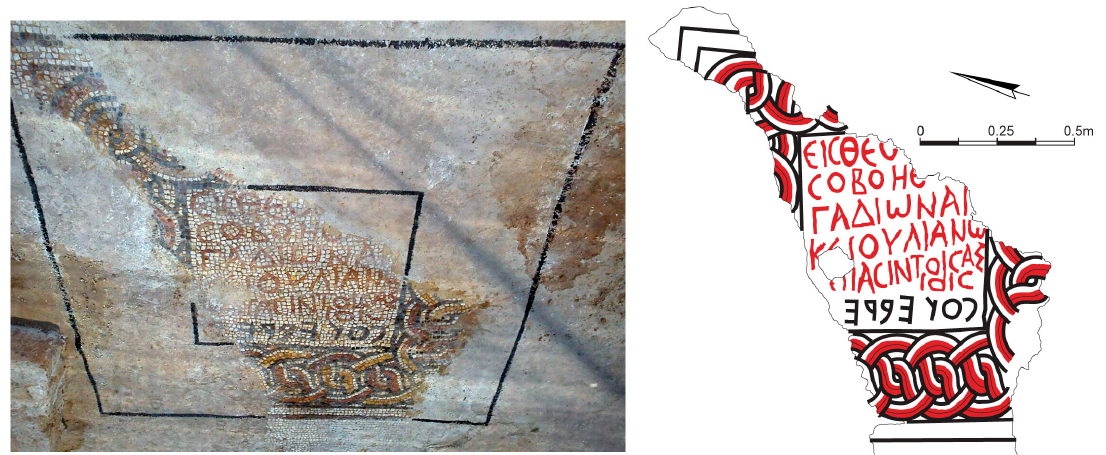
Figure 5. Apollonia-Arsuf, Area P1, the inscription, photo (on left, after restoration) and drawing (on right; Slava Pirsky).